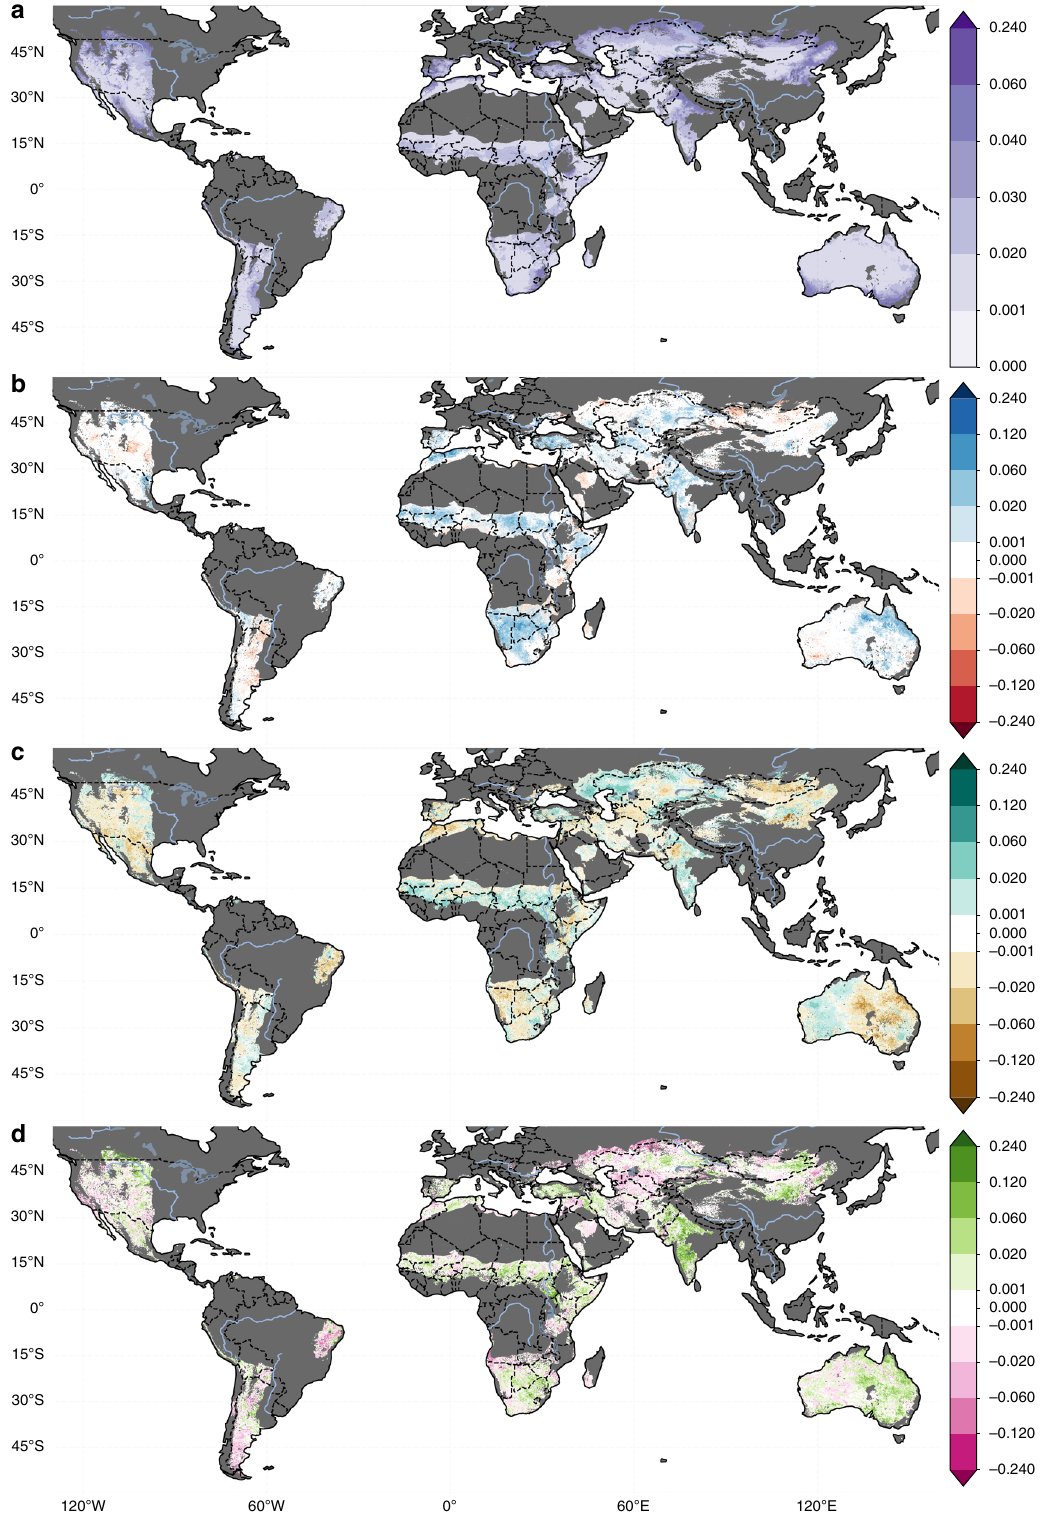
Fig. 4 The drivers of global vegetation change. The changes in NDVI max between 1982 and 2015 ( Δ NDVI max ) attributed to ( a ) CO 2 fertilization, ( b ) climate variability, ( c ) climate change, and ( d ) land use. Non-dryland and hyper-arid regions are masked in dark gray. Areas where the change did not meet the multi-run ensemble signi fi cance criteria detailed in the “ Methods, ” or are smaller than the error in the sensors (±0.001) are masked in